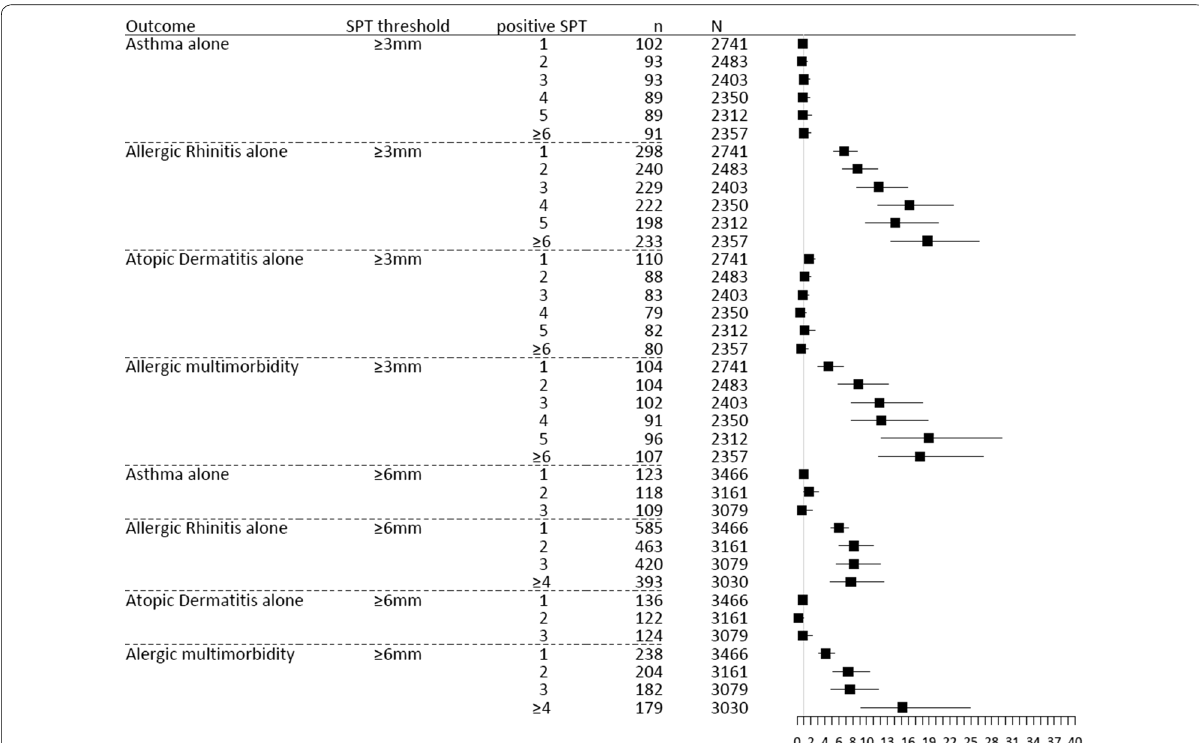
Fig. 4 Association between allergen sensitization for number of subjects with a confirmed diagnosis. N—total number of subjects in the analysis (with 0 positive SPT or x SPT, where x is number of positive SPT)